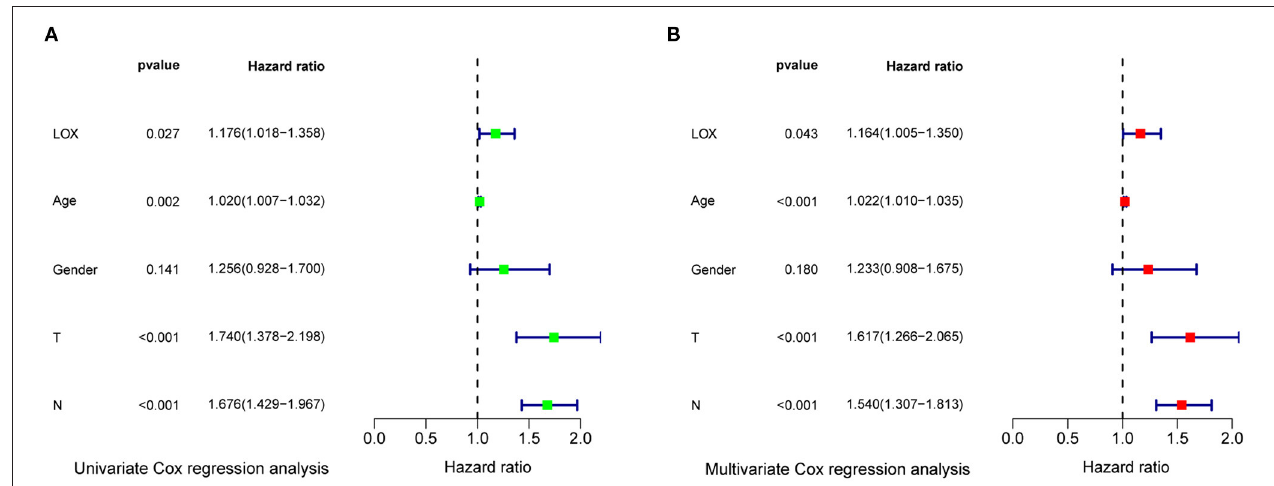
FIGURE 5 | Forest plot of the correlation between LOX expression and overall survival in GC patients based on GEO data. (A) Univariate Cox regression analysis. (B) Multivariate Cox regression analysis. GEO, the Gene Expression Omnibus.